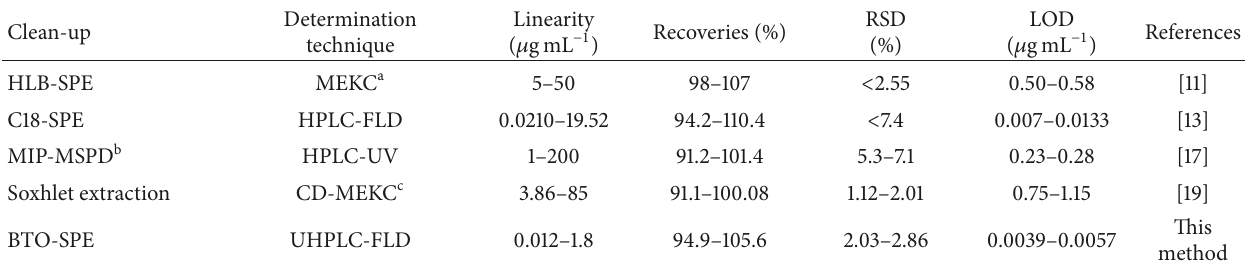
Table 4: Comparison of BTO-SPE-FLD method with other methods for the determination of anthraquinones.